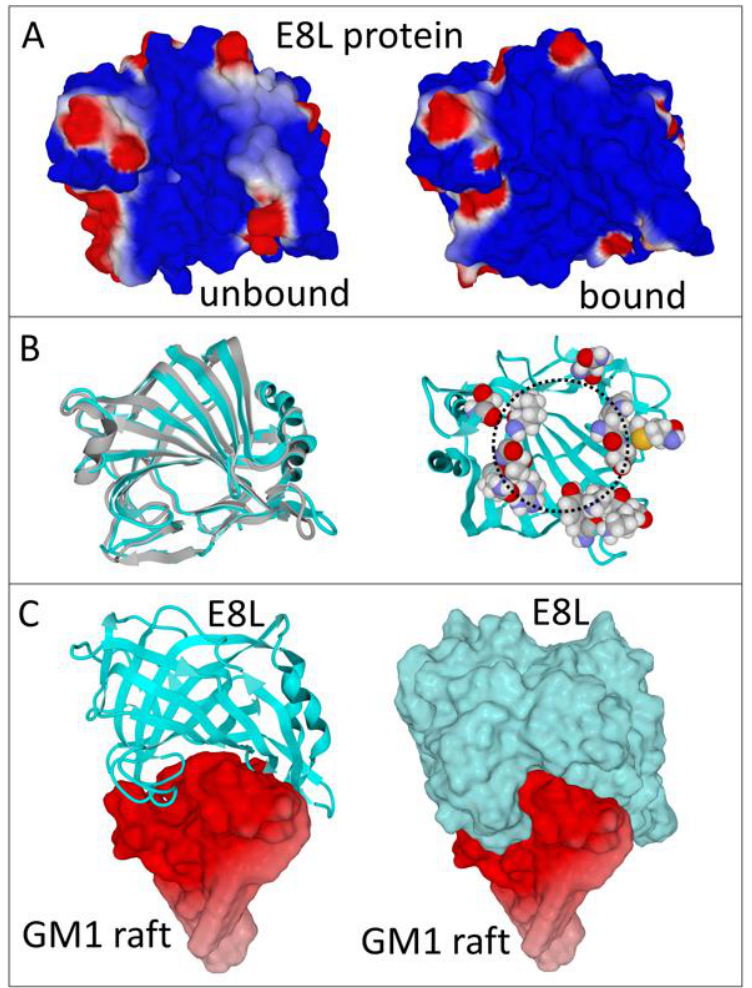
Figure 1. Identification of a ganglioside-binding site at the tip of the E8L monkeypox virus protein. ( A ) Electrostatic surface potential of the E8L protein side facing the host cell. Two conformations (unbound and bound to gangliosides) are shown. Electropositive, electronegative, and neutral regions are colored in blue, red, and white, respectively. Note the increase of electropositive sur- faces on the bound protein. ( B ) Secondary structure organization of the E8L protein before (grey) and after binding to gangliosides (cyan). Both structures are superposed on the left panel. On the right panel, the annular distribution (dashed circle) of the amino acid residues involved in gangli- oside binding are represented in atomic spheres (carbon in grey, oxygen in red, nitrogen in blue, hydrogen in white, sulfur in yellow). ( C ) E8L protein bound to a cluster of gangliosides GM1 in a typical lipid raft organization. On the left panel, the E8L protein is represented in ribbons. On the right panel, the protein is shown in surface rendering. In both cases the electrostatic surface poten- tial of the GM1 raft is shown.